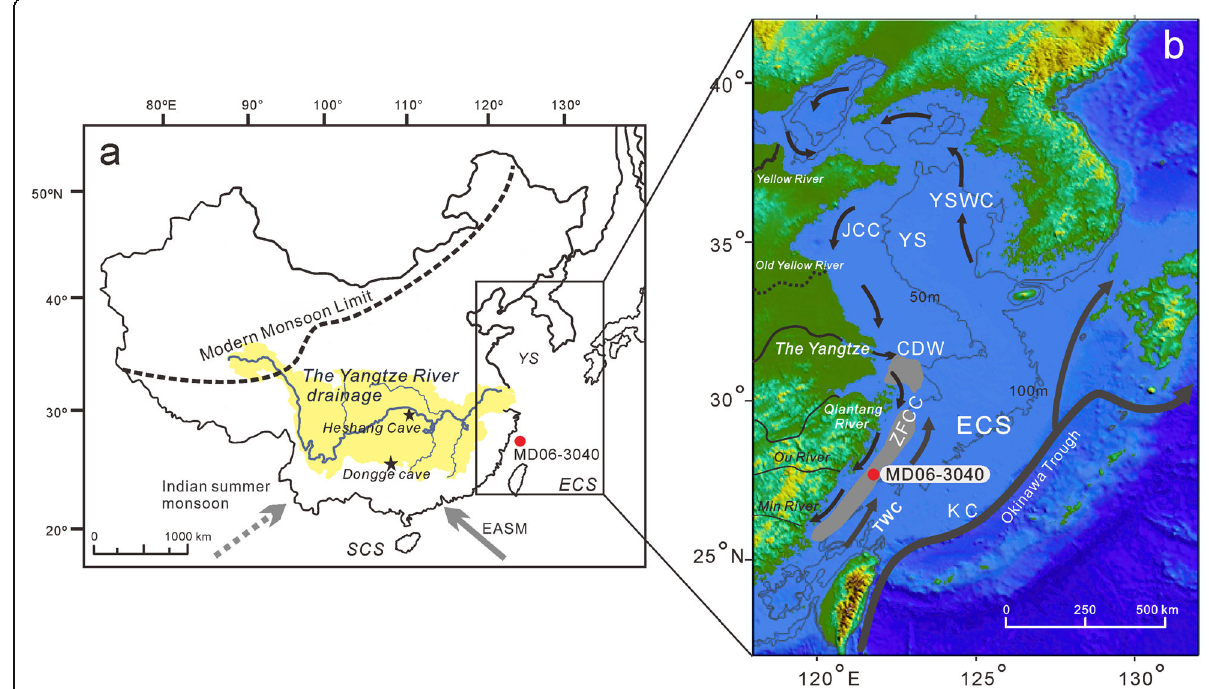
Fig. 1 Map ( a ) showing the Yangtze drainage (yellow area), the location of the MD06-3040 core used in this study, and two Holocene stalagmite δ 18 O sites. The modern EASM limit is shown by the black dashed line according to Chen et al. (2015). Map ( b ) showing the regional oceanic circulation pattern in the East China Sea (ECS) and Yellow Sea (YS). CDW, Changjiang Dilute Water; ZFCC, Zhejiang-Fujian Coastal Current; JCC, Jiangsu Coastal Current; YSWC, Yellow Sea Warm Current; TWC, Taiwan Warm Current; KC, Kuroshio Current. The gray shaded areas represent the mud belts distributed from the Yangtze River estuary to the southwest along the shoreline of South China on the inner shelf of the ECS